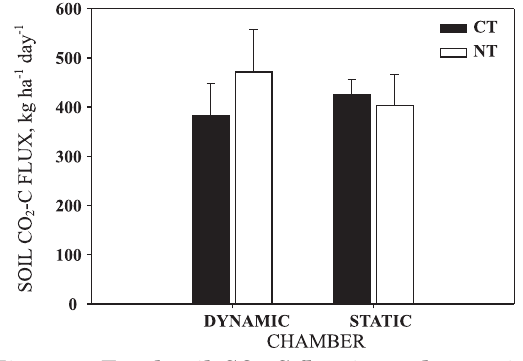
Figure 3. Total soil CO -C flux in 30 day period in 2 conventional tillage (CT) and no-tillage (NT) in intensive cropping system measured in dynamic and static chambers. The vertical bars represent the mean standard